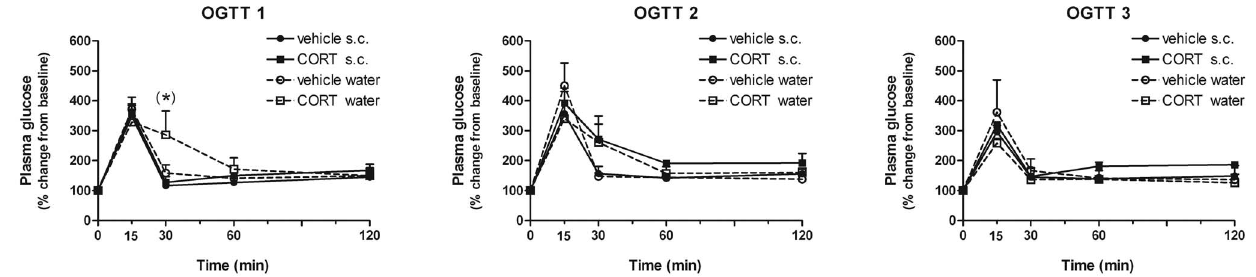
Figure 4. Plasma glucose levels (mean % change from baseline + S.E.M.) after acute glucose challenge in fasted animals receiving corticosterone (CORT) or vehicle either orally via the drinking water or by daily s.c. injection as measured by oral glucose tolerance tests (OGGT). Within each OGTT, plasma glucose levels are measured at baseline (0) and 15, 30, 60 and 120 min after an oral administration of glucose. Treatment effects upon glucose tolerance were measured at 3 time-points throughout the experiment, namely directly after 4 weeks treatment (OGTT1) and 1 and 2 weeks after treatment cessation (OGTT2, OGTT3, respectively). (*) trend ; P =0.094.